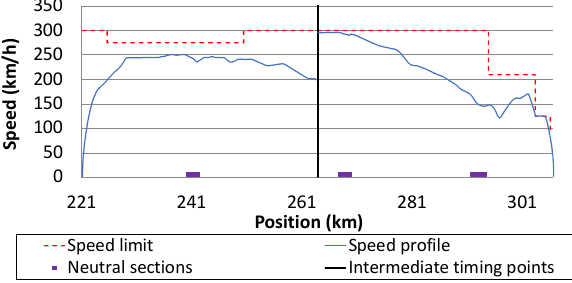
Figure 3. Speed profile obtained optimizing independently each section between target times.